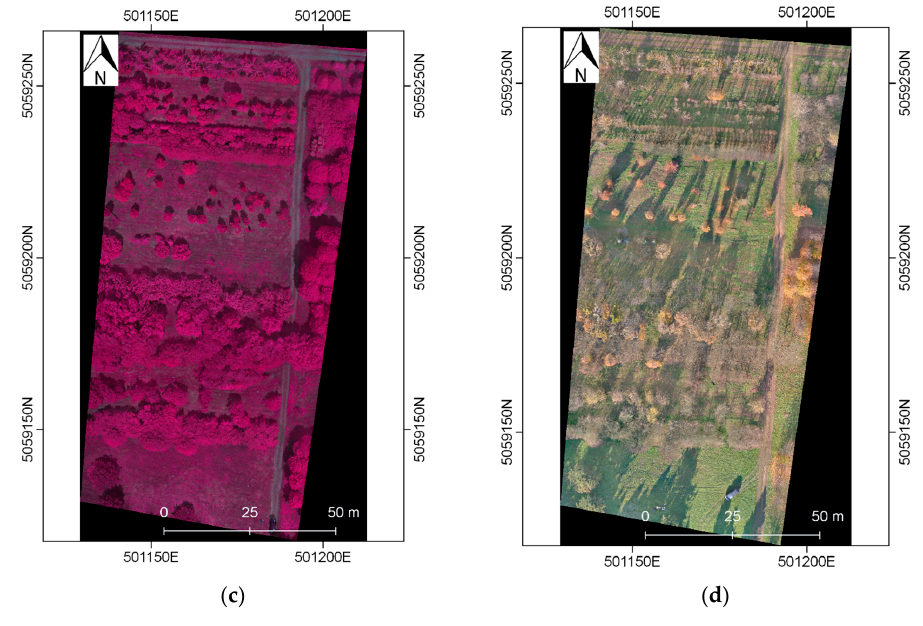
Figure 4. Photogrammetric products: DSM ( a ) and orthomosaics: RGB_S ( b ), CIR_S ( c ) and RGB_A ( d ). The georeferencing accuracies of the orthophotos were evaluated by means of the 14 surveyed ground points (one GPS surveyed point was eliminated due to gross errors). The Root Mean Square Errors (RMSE) on single coordinate of GCPs, reported in Table 2, are all lower than 5 cm, thus maintaining the global accuracy of the orthophotos consistent with the GPS survey accuracy. Table 2. Statistics of the differences with respect to the surveyed ground points (m).